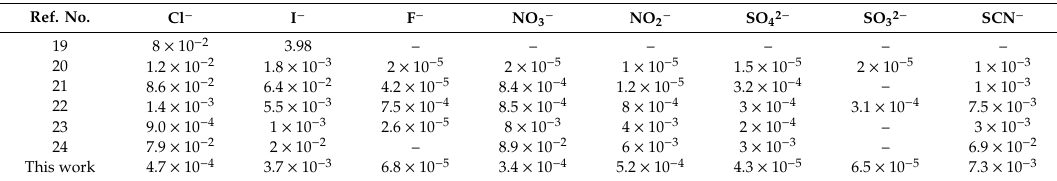
Table 1. Selectivity coe ffi cient of various interfering anions.